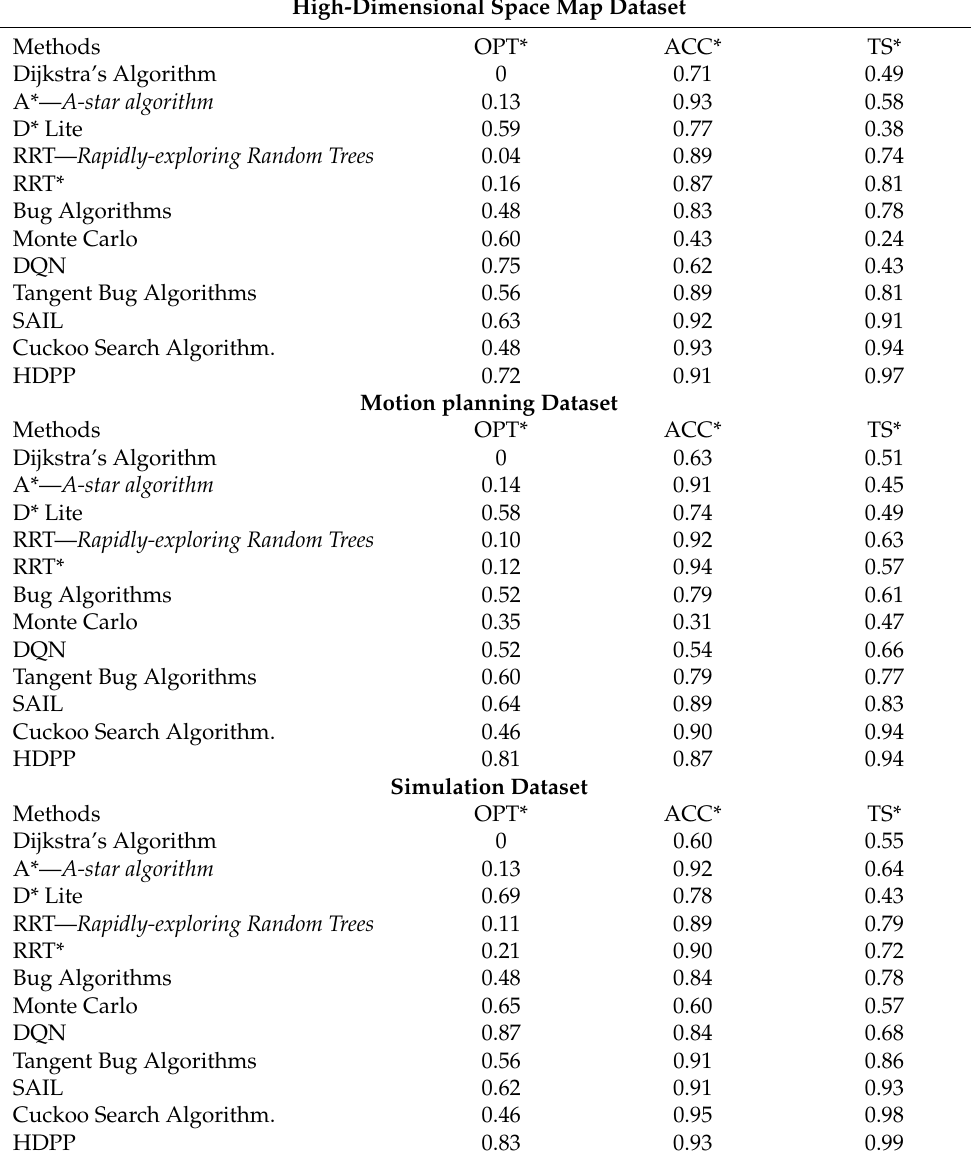
Table 2. Comparison on 6 DOF (degree-of-freedom) robotic arm. We conducted 50 tests on sports in 10 scenarios. We use the three metrics mentioned in Section 4.3. to quantify performance. High-Dimensional Space Map